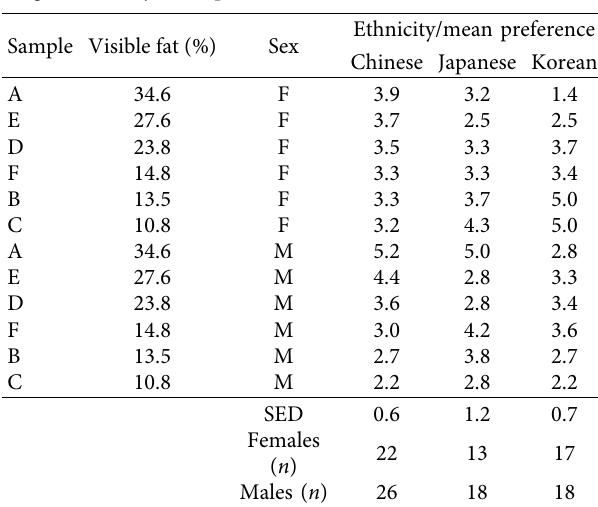
Figure 5: The frequency of ranking separated by gender, with the rank of 1 as the least preferred and 6 the most preferred. Samples are ordered from highest (A) to lowest (C) percentage of visible fat along the x -axis. A � 35%, E � 28%, D � 24%, F � 15%, B � 14%, and C � 11%. Table 1: The Chinese, Japanese, and Korean mean preference Table 2: The Chinese, Japanese, and Korean mean preference (1 � least preferred; 6 � most preferred) of the samples for the age (1 � least preferred; 6 � most preferred) of the samples for the age range of 19–30years separated into females (F) and males (M). range of 31–50years separated into females (F) and males (M).